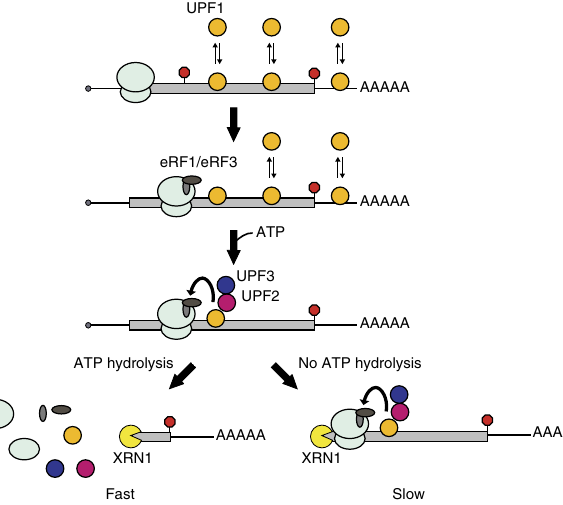
Figure 5 | ATP hydrolysis by UPF1 promotes efficient translation termination on nonsense-containing mRNAs. Premature translation termination allows UPF1 to remain associated with transcripts at sites downstream of the PTC and in a 3 0 UTR length-dependent manner. ATP binding by UPF1, in conjunction with cofactors UPF2 and UPF3,